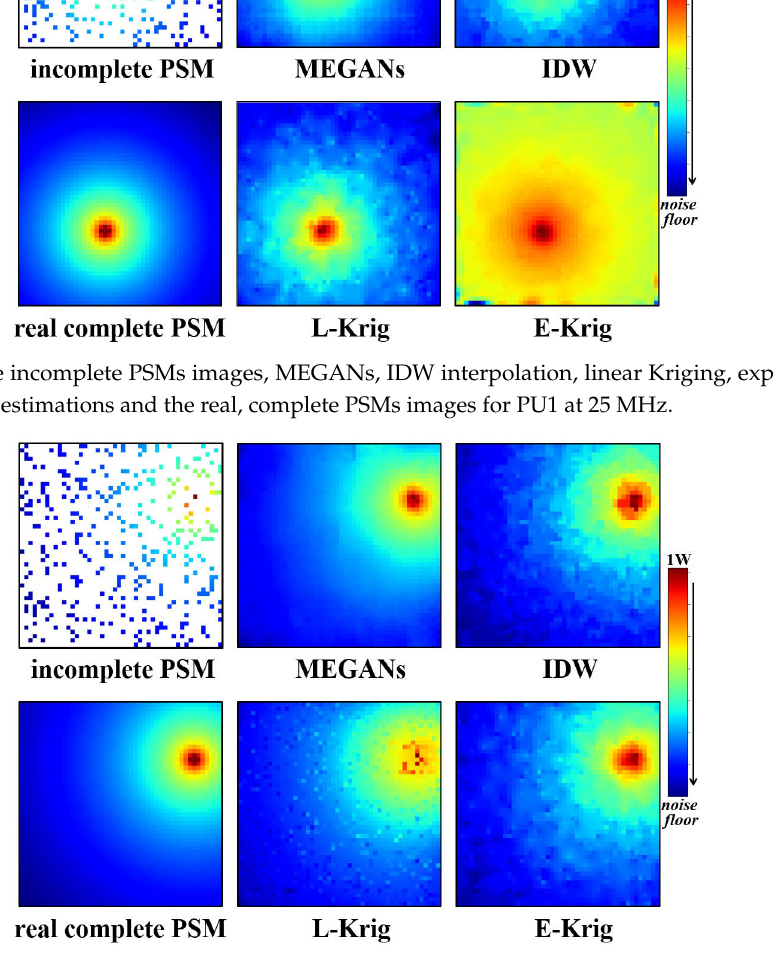
Figure 11. The incomplete PSMs images, MEGANs, IDW interpolation, linear Kriging, exponential Kriging PSMs estimations and the real, complete PSMs images for PU2 at 75